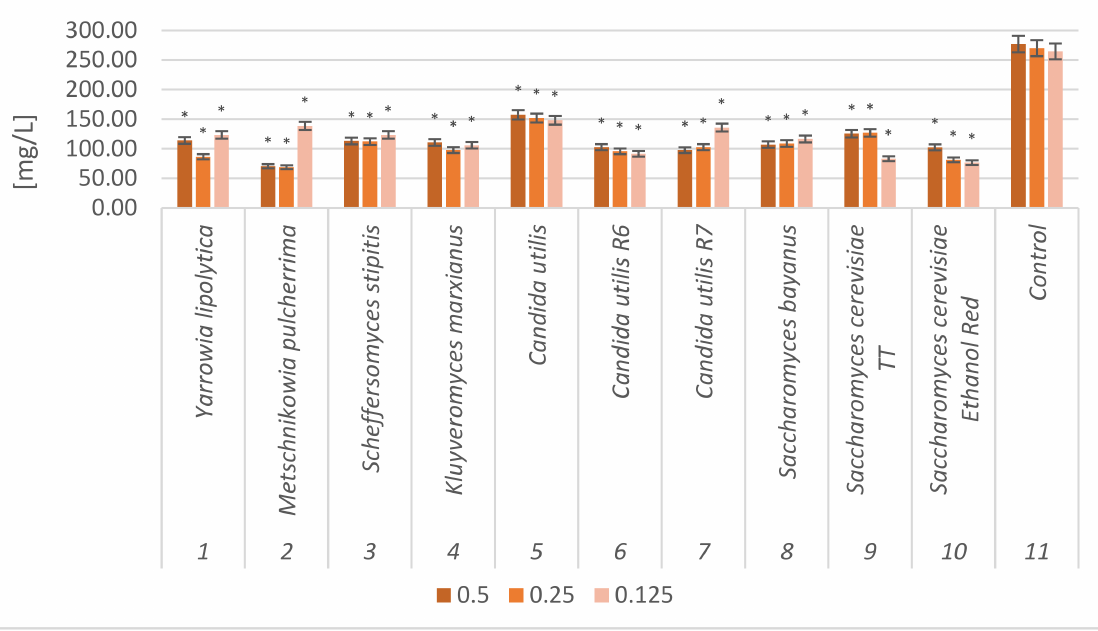
Figure 5. Free amino nitrogen (FAN) content in dried sugar beet pulp samples after yeast cul- tivation. The biomass was hydrolyzed with different enzyme concentrations (0.5 mL/10 g DM; 0.25 mL/10 g DM; 0.125 mL/10 g DM). *—indicator of statistical difference relative to the control sample ( p <